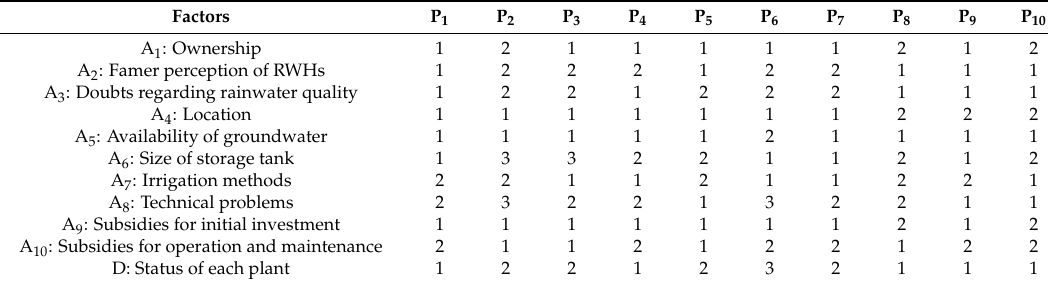
Table 4. Codified data matrix of 10 factors and operational status of 10